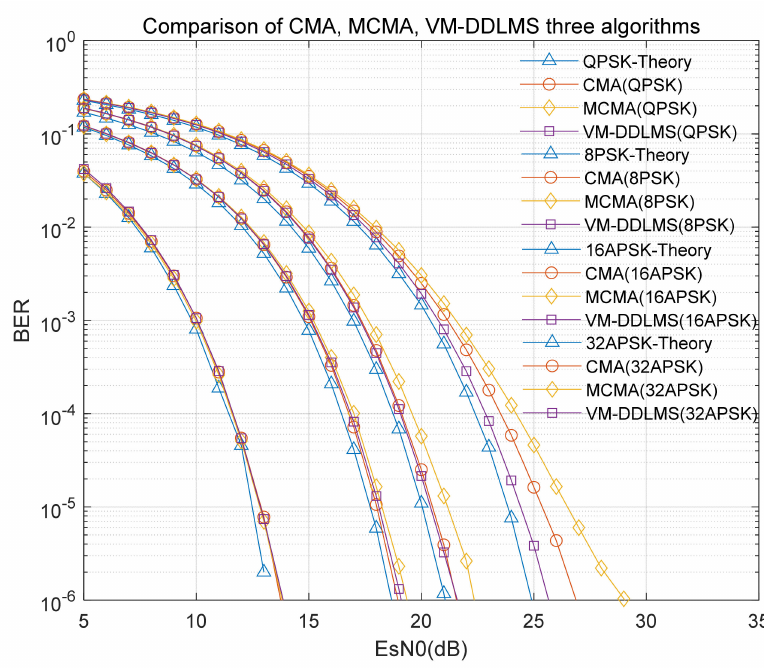
Figure 7. Comparison of the BER curves of three equalization algorithms.